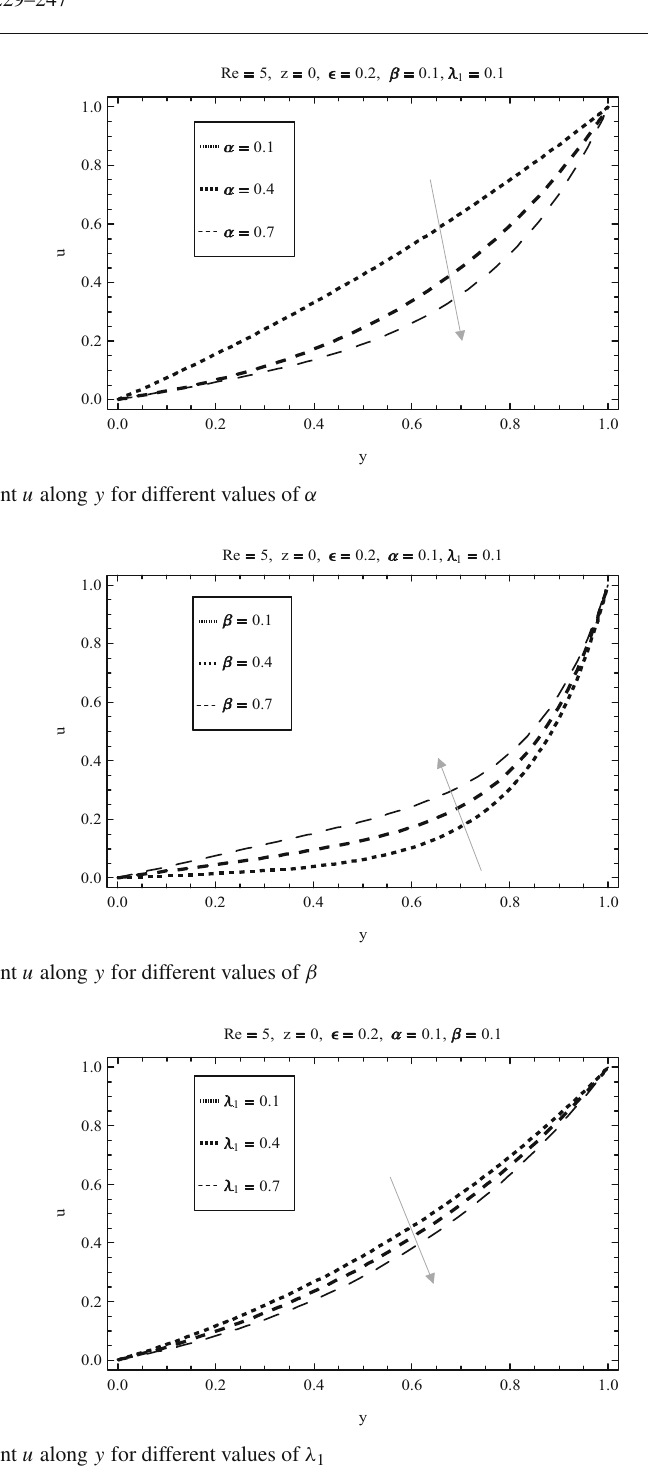
The influence of injection/suction parameter α , the Deborah number β , the ratio of relaxation time to the retardation time λ 1 and Reynolds number Re on secondary flow velocity component v are shown in Figs. 6, 7, 8 and 9, respectively. It is observed that the velocity v increases with increasing the injection/suction parameter, the Deborah number, the ratio of relaxation time to the retardation time and Reynolds number. It means that all the physical parameters provide a mechanism to enhance the velocity v . Moreover, the velocity profile